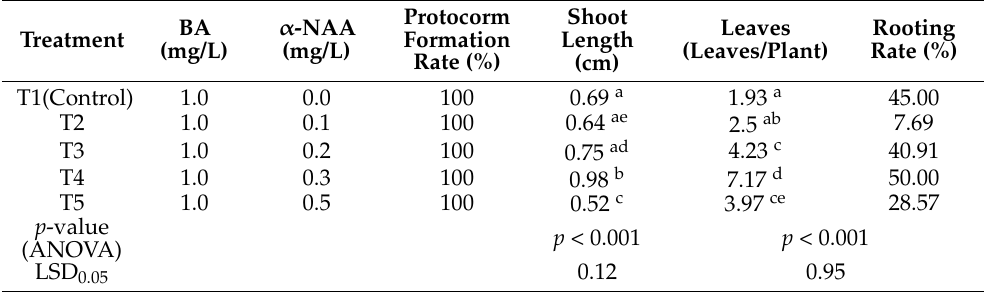
Table 3. Effect of BA and α -NAA on the regeneration efficiency of D. anosmum Lindl. protocorms (10 weeks after